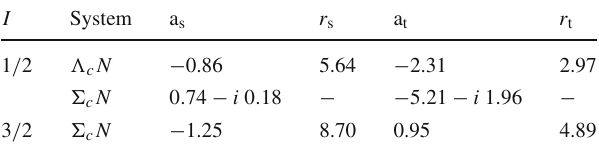
Fig. 3 a Dependence of the HAL QCD (cid:2) c N 1 S 0 scattering length on the pion mass [44]. The vertical bars include statistical and systematic errors. The purple diamond represents the prediction of the CQM for the physical pion mass. b Same as ( a ) for the (cid:2) c N 3 S 1 partial wave Table 3 CQM results for the 1 S 0 and 3 S 1 scattering lengths (a s and a t ) and effective range parameters ( r s and r t ) in fm for the different Y c N